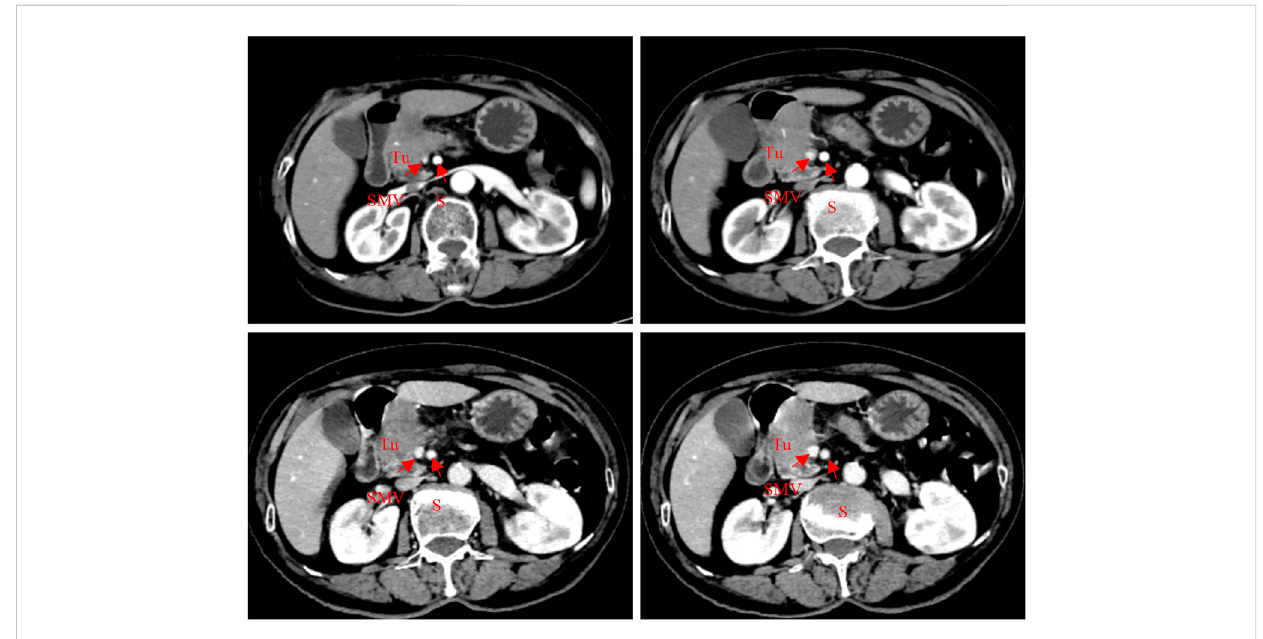
FIGURE 1 Abdominal CT scan (2022-08-05): a soft tissue mass shadow was seen in the pancreas head, approximately 57*32 mm; meanwhile, the gastroduodenal artery and superior mesenteric vein were also